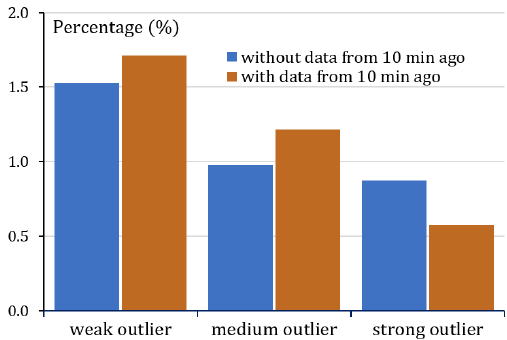
Figure 4. Percentage of classes of outliers (weak, medium, and strong) when analysing the data from two types of sensors (un- heated and heated) separately (blue) or together (brown). Data from 22 May 2019.